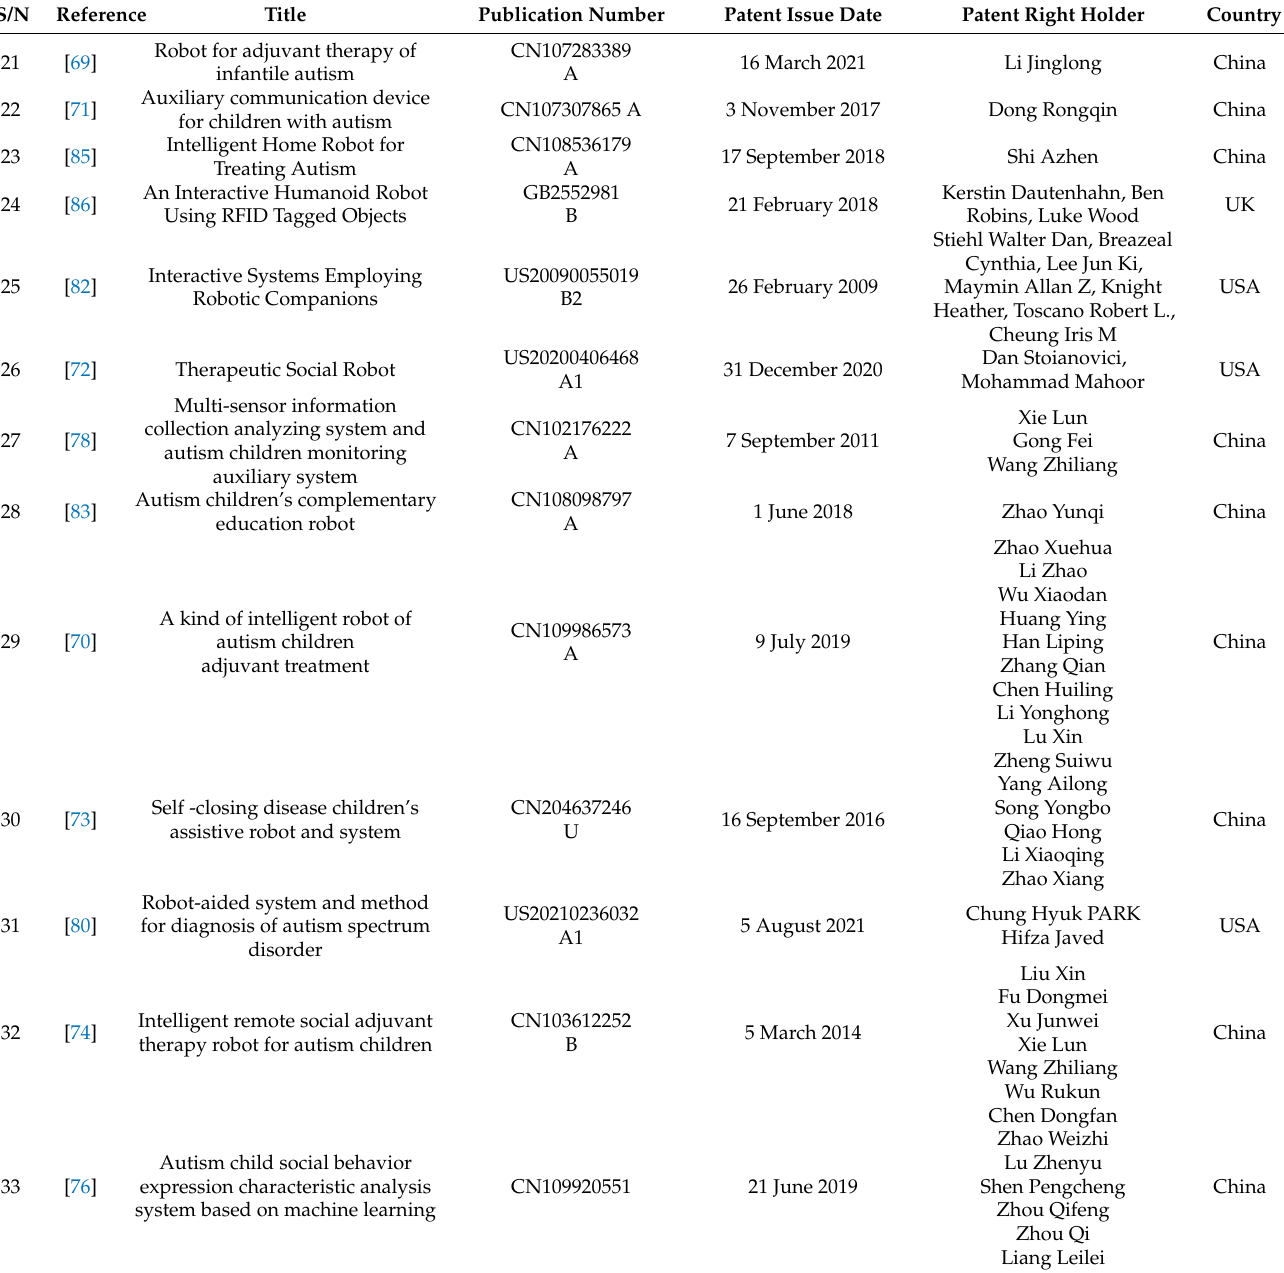
Table 11. Sample of assistive technology patents in the form of